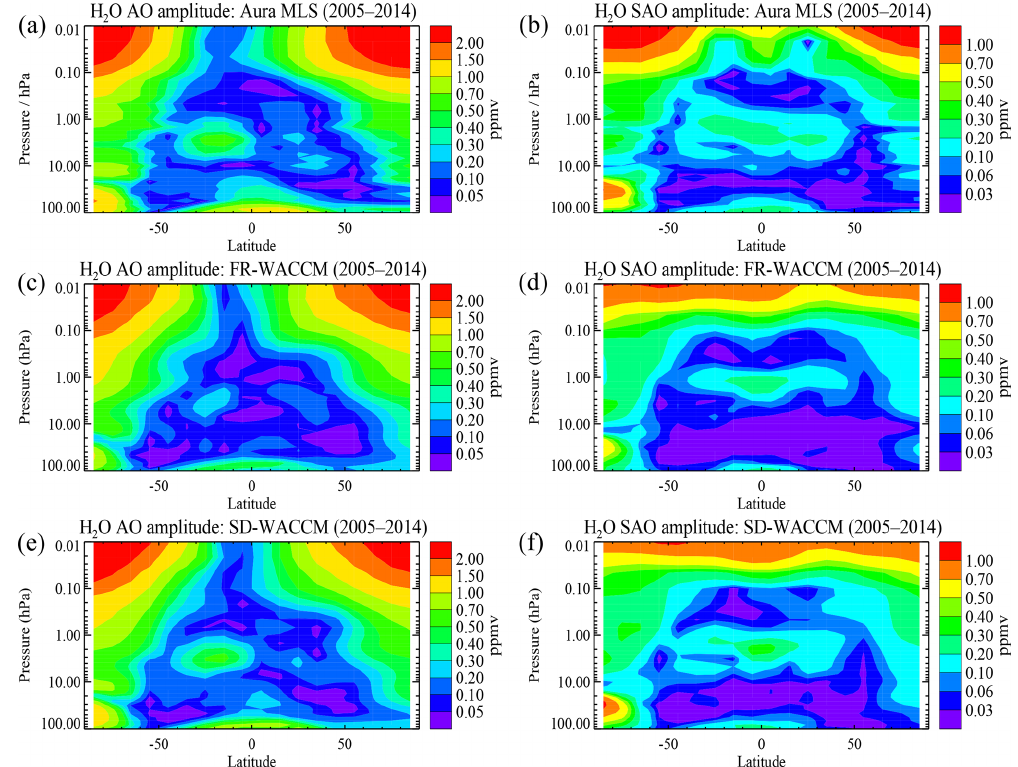
Figure 9. Same as Fig. 8 but for H 2 O annual and semiannual cycles in the stratosphere and mesosphere.